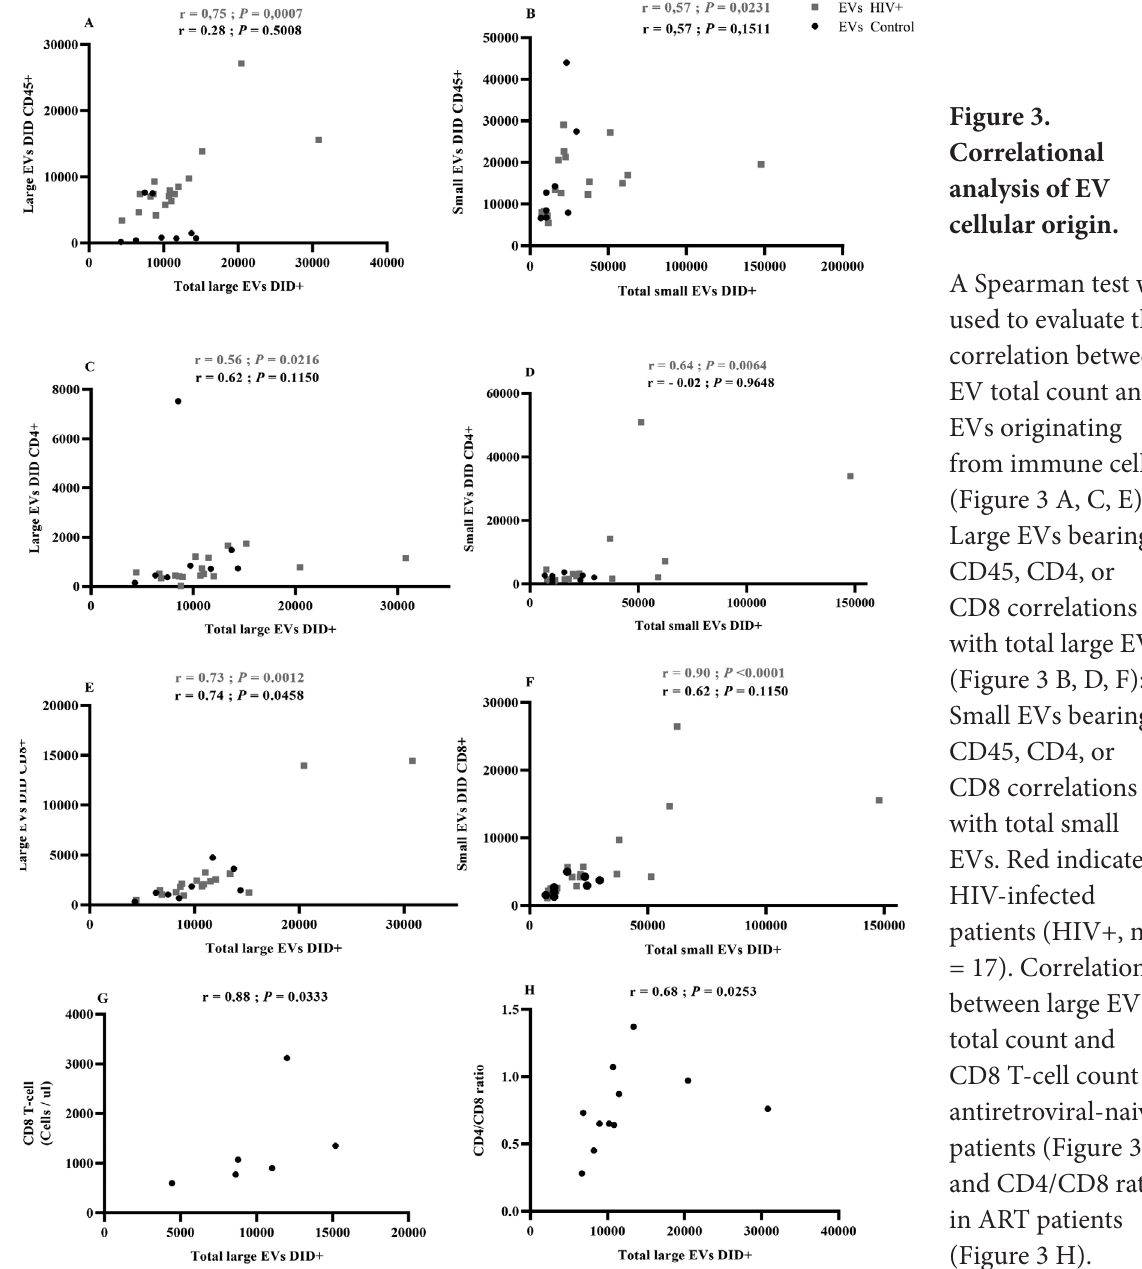
Figure 3. Correlational analysis of EV cellular origin. A Spearman test was used to evaluate the correlation between EV total count and EVs originating from immune cells. (Figure 3 A, C, E): Large EVs bearing CD45, CD4, or CD8 correlations with total large EVs; (Figure 3 B, D, F): Small EVs bearing CD45, CD4, or CD8 correlations with total small EVs. Red indicates HIV-infected patients (HIV+, n = 17). Correlations between large EV total count and CD8 T-cell count in antiretroviral-naive patients (Figure 3G) and CD4/CD8 ratio in ART patients (Figure 3